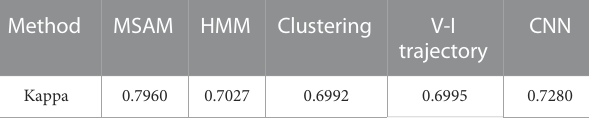
classi fi cation accuracy achieved by the model. kappa coef fi cient